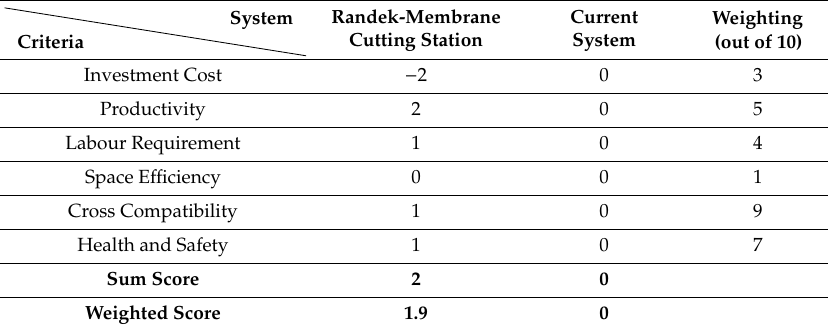
Table 9. Resultant scores for the building wrap process.